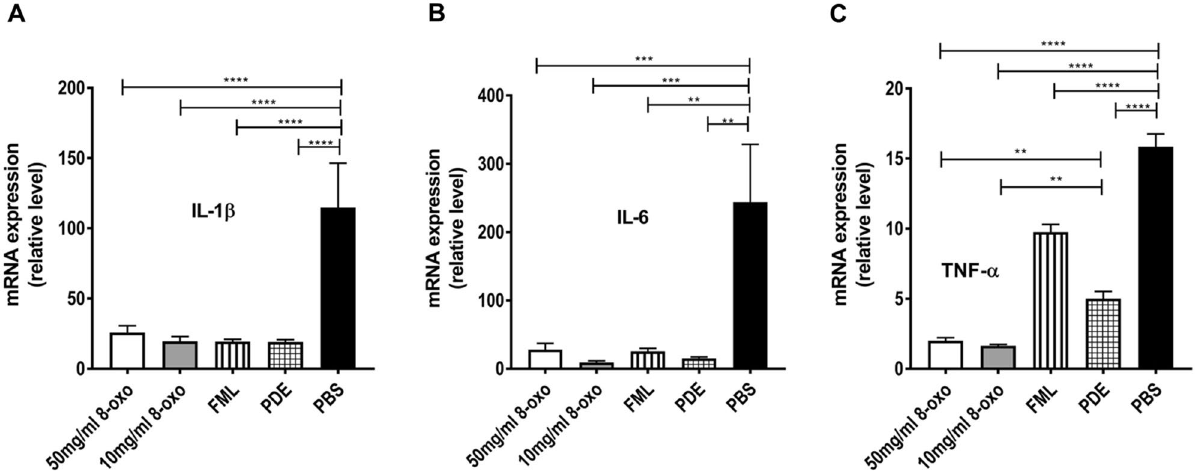
Figure 5. Real-time reverse transcription-polymerase chain reaction (PCR) assay of corneal specimens 1 week after treatment of ocular alkali burn model with topical 8-oxo-2 ′ -deoxyguanosine (8-oxo-dG) or corticosteroid. Relative mRNA expression levels of IL-1β ( A ), TNF-α ( B ), and IL-6 ( C ). Data are presented as means ± standard error of the mean (SEM). ** p < 0.01. 8-oxo: 8-oxo-dG. FML fluorometholone 0.1% (1 mg/mL), PDE